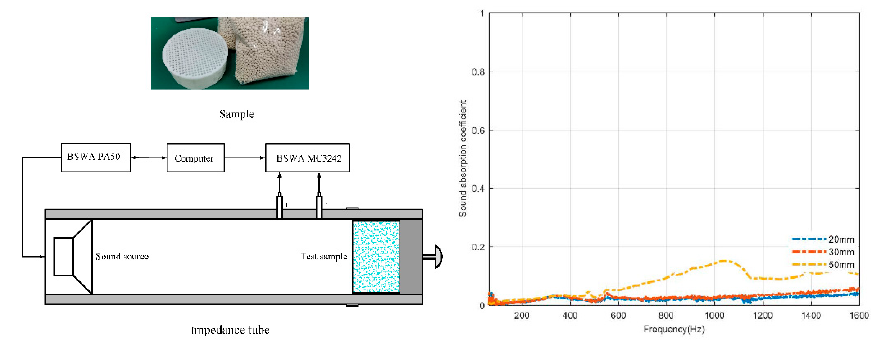
Figure 1. Experiment setup. On the left are the sample and the impedance tube, and on the right is the absorption coefficient of the cylindrical box.